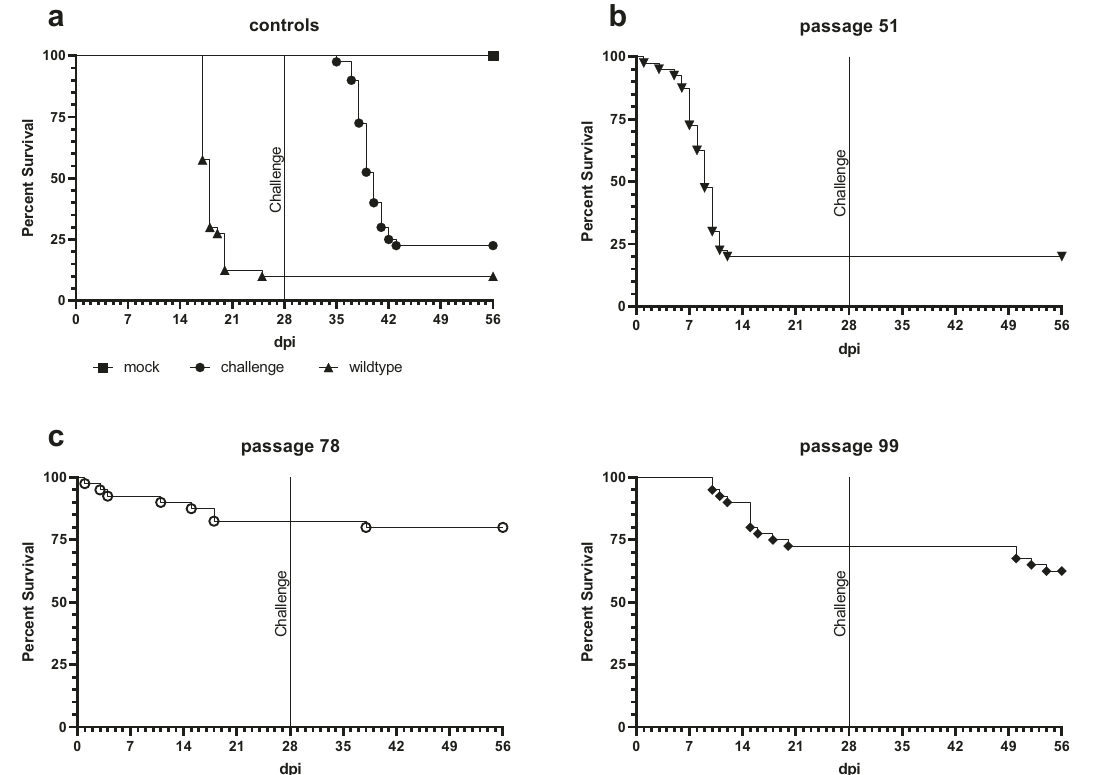
Fig. 1 In vivo testing of different KHV-T passages. Survival data of carp infected with different CCB cell passages of KHV-T b – d compared to wild-type or mock infected animals a . The carp were infected with 10 5 TCID 50 /mL of the indicated passage and, except one control group, challenged after 28 dpi with the same dose of wildtype